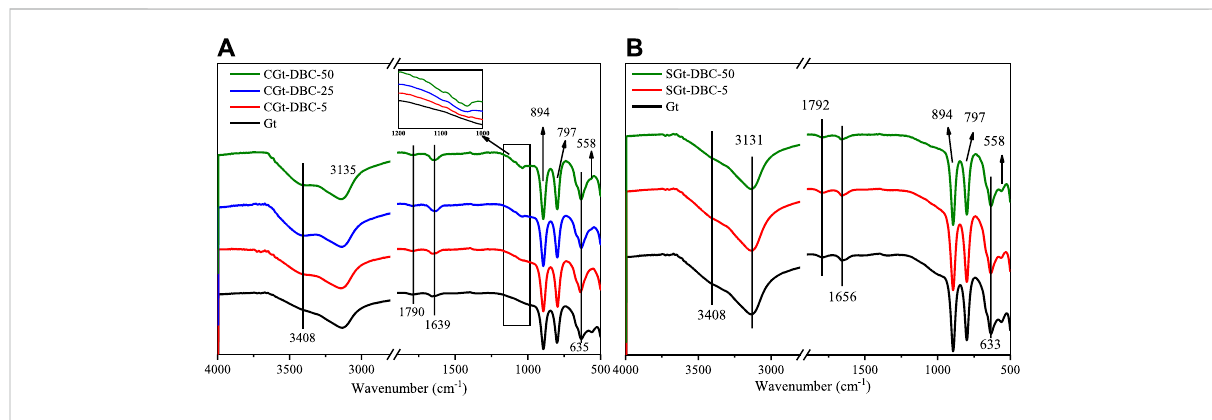
FIGURE 4 FTIR spectra of Gt and Gt-DBC samples (CGt-DBC, the coprecipitated Gt-DBC complexes; SGt-DBC, the adsorbed Gt-DBC complexes; Numbers indicate the additive concentration of DBC in the preparation of Gt-DBC